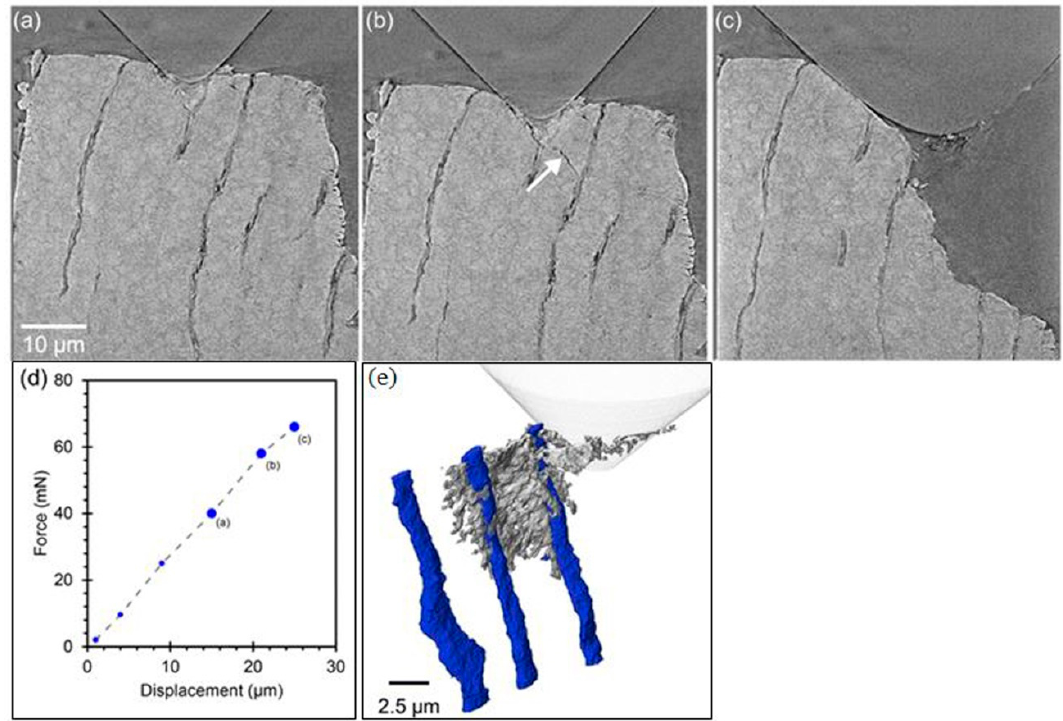
Figure 10. ( a – c ) 2D slices showing crack evolution corresponding to the different stages of indenter loading. ( d ) The force-displacement curve during the nano-indentation test. ( e ) 3D volume rendering of an extracted crack at the loading point ( b ) on the force-displacement curve showing the relationship of the crack with selected dentin tubules [31].